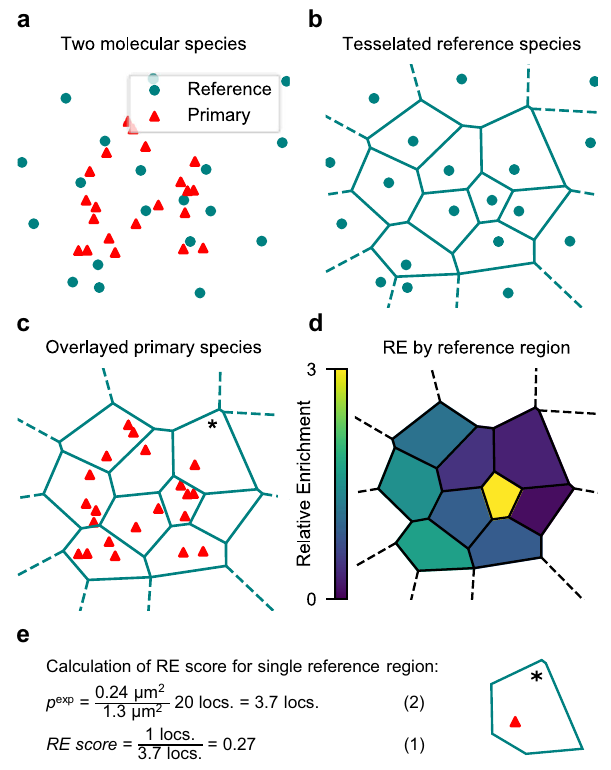
Fig. 1 | Tessellation-based assessment of relative enrichment. a Simulated ran- domdistributionoftwomolecularspecies.Forcomputationofrelativeenrichment (RE)oneisassignedastheprimaryspeciesandoneasthereferencespecies.REcan be bidirectionally computed and will by design yield different results if the two species are switched. b Voronoï-regions from tessellation of the reference species from ( a ). c Primary species superimposed on the Voronoï-regions of the reference species. d Voronoï-regions for the reference species, color-coded by their indivi- dual RE scores. All calculated as in panel ( e ). e Calculation of single RE value from Voronoï-region marked with (*) in c, based on the distribution of the primary